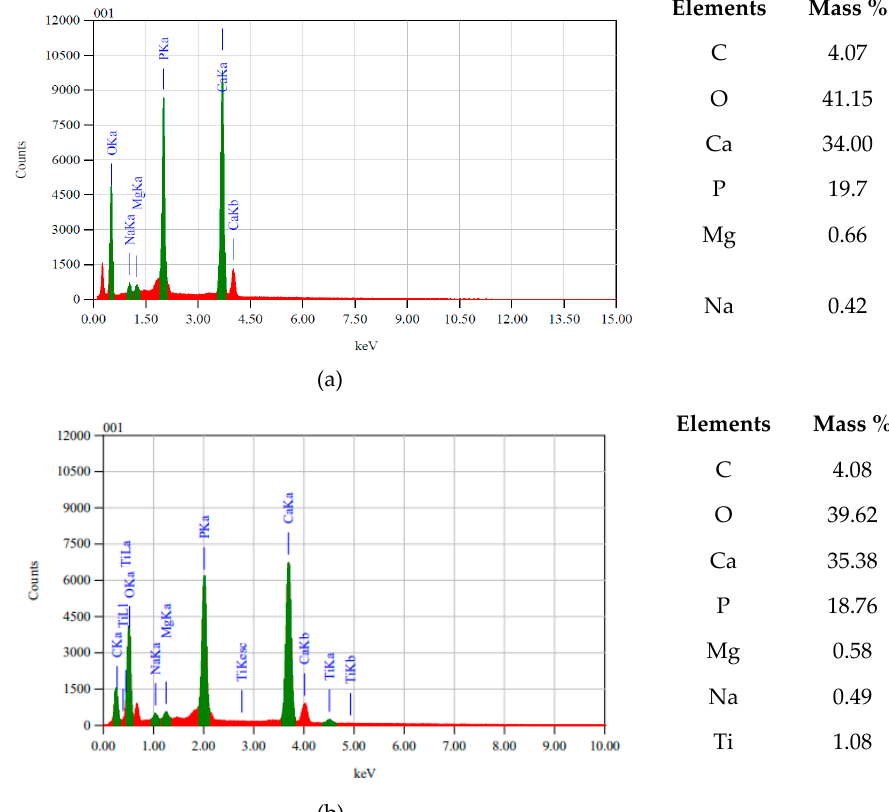
Figure 2. EDS analyses for ( a ) BC900 and ( b ) (BC/nTiO 2 ) P.